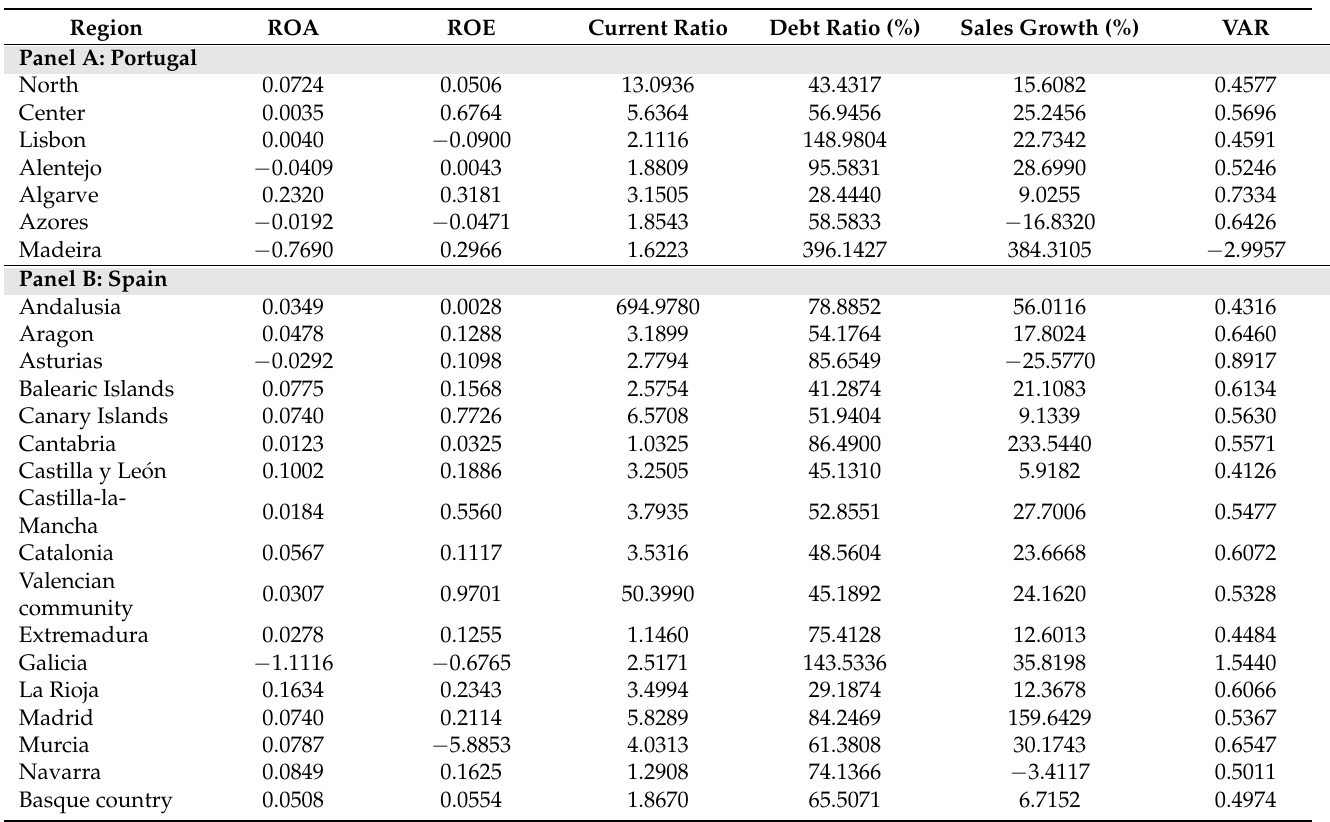
Table 4. Mean values for financial ratios, by NUTs II regions,